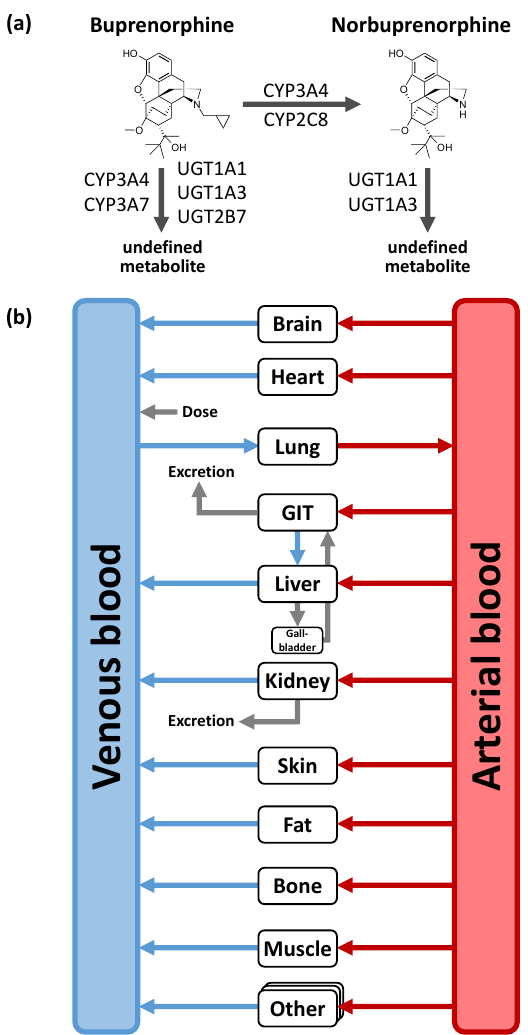
Figure 1. Implemented metabolic processes for buprenorphine and norbuprenorphine ( a ) and structural overviewofthephysiologically-basedpharmacokinetic(PBPK)model( b ). Boxesindicatecompartments, black lines indicate metabolic processes, blue, grey and red lines denote in- / out-flows. CYP: cytochrome P450, GIT: gastrointestinal tract, UGT: uridine 5 (cid:48)